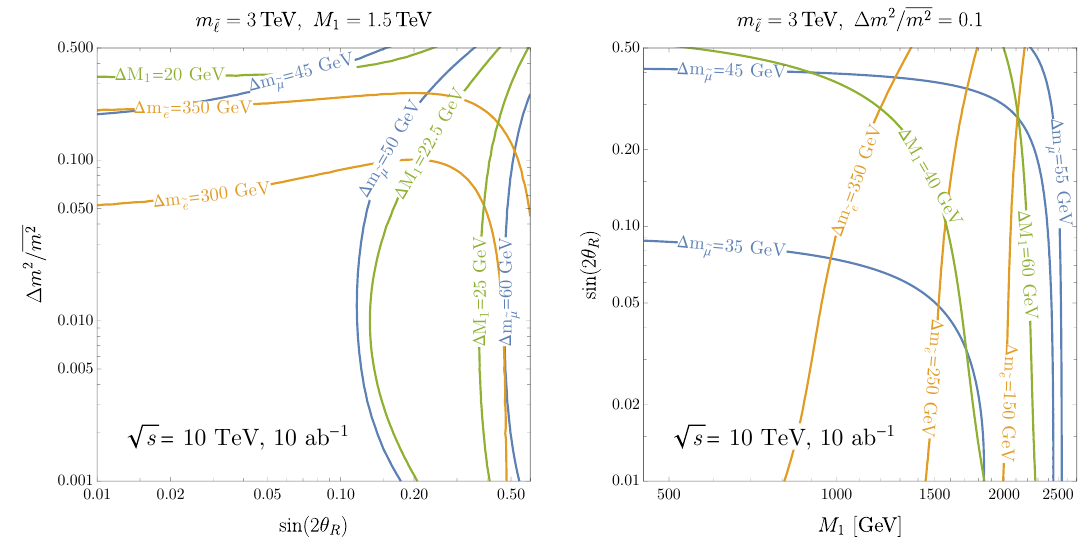
Figure 2. Contours of the expected precision on the selectron, smuon and neutralino masses as a function of sin 2 θ R and ∆ m 2 /m 2 for fixed m ˜ and M 1 (left) and as a function of M 1 and sin 2 θ R ‘ √ s = 10 TeV, assuming 10 ab − 1 of for fixed m ˜ and ∆ m 2 /m 2 (right), all at ‘